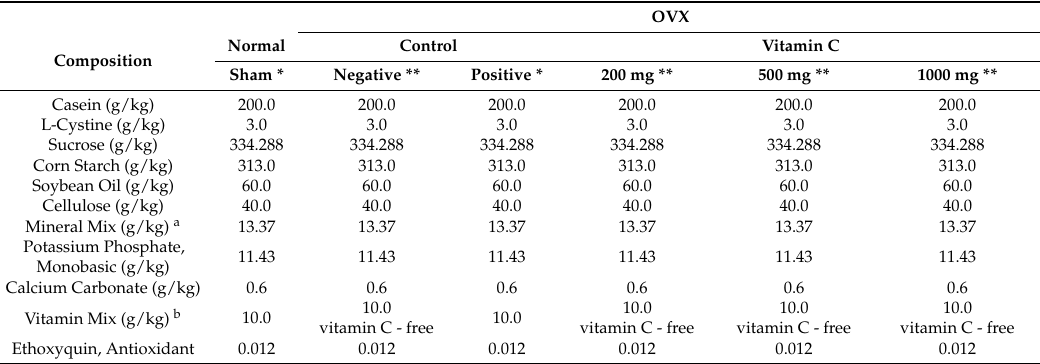
Table 2. Composition of experimental